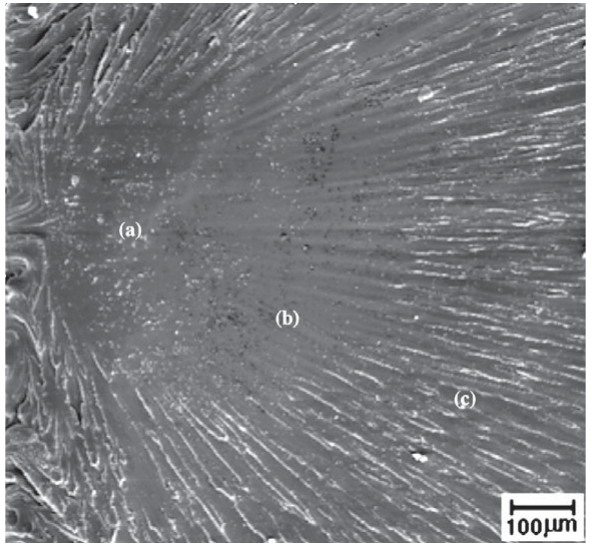
three regions present at the fracture surface of a thermoset poly- mer: a) the mirror zone; b) the transition zone; c) the final propa- gation zone.